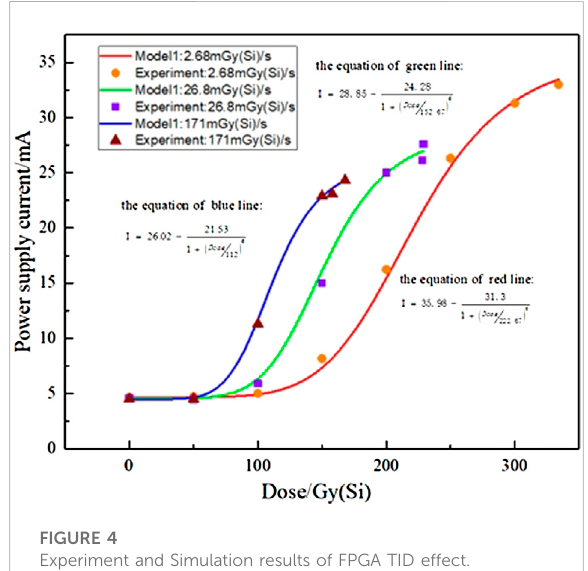
FIGURE 4 Experiment and Simulation results of FPGA TID